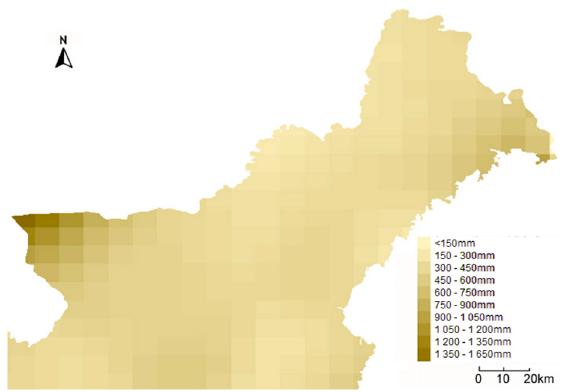
Figure 16. The map of average annual evaporation evaluated for 50 years in the Tumen River Basin